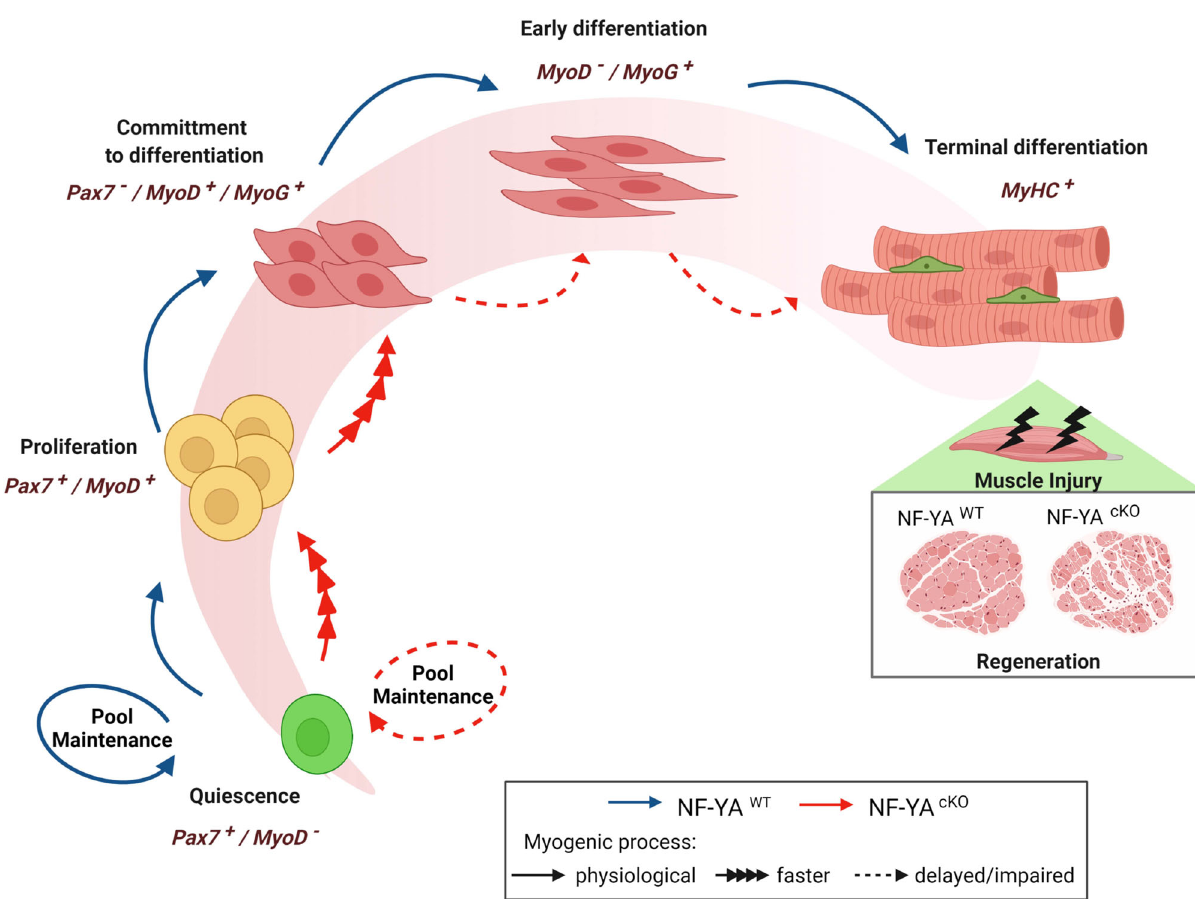
Fig. 8 Model for NF-Y role in skeletal muscle stem cells. Comparison between myogenic progression of SCs expressing physiological or reduced NF-YA levels (blue lines = NF-YA WT ; red lines = NF-YA cKO ). Quiescent SCs that survive to NF-YA loss (NF-YA cKO ) are quickly activated and committed to